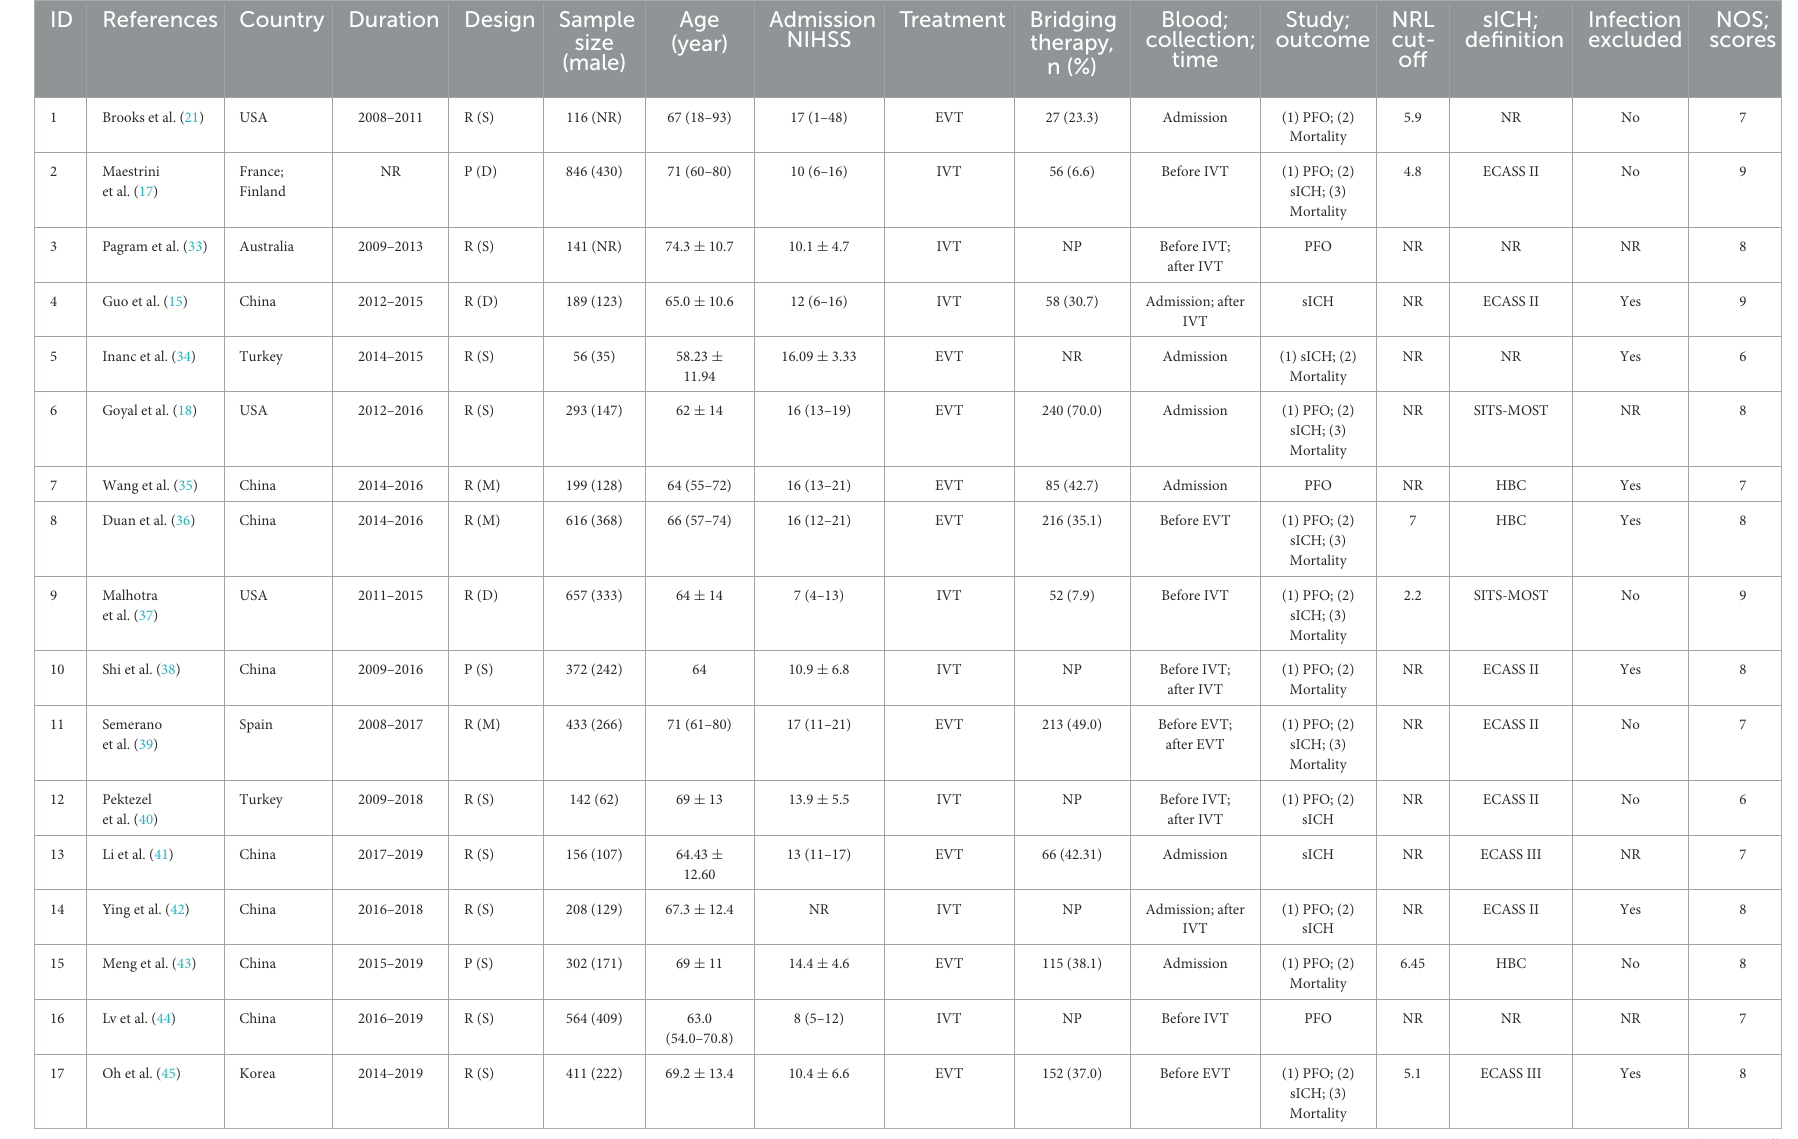
TABLE 1 Basic characteristics of the studies included in the